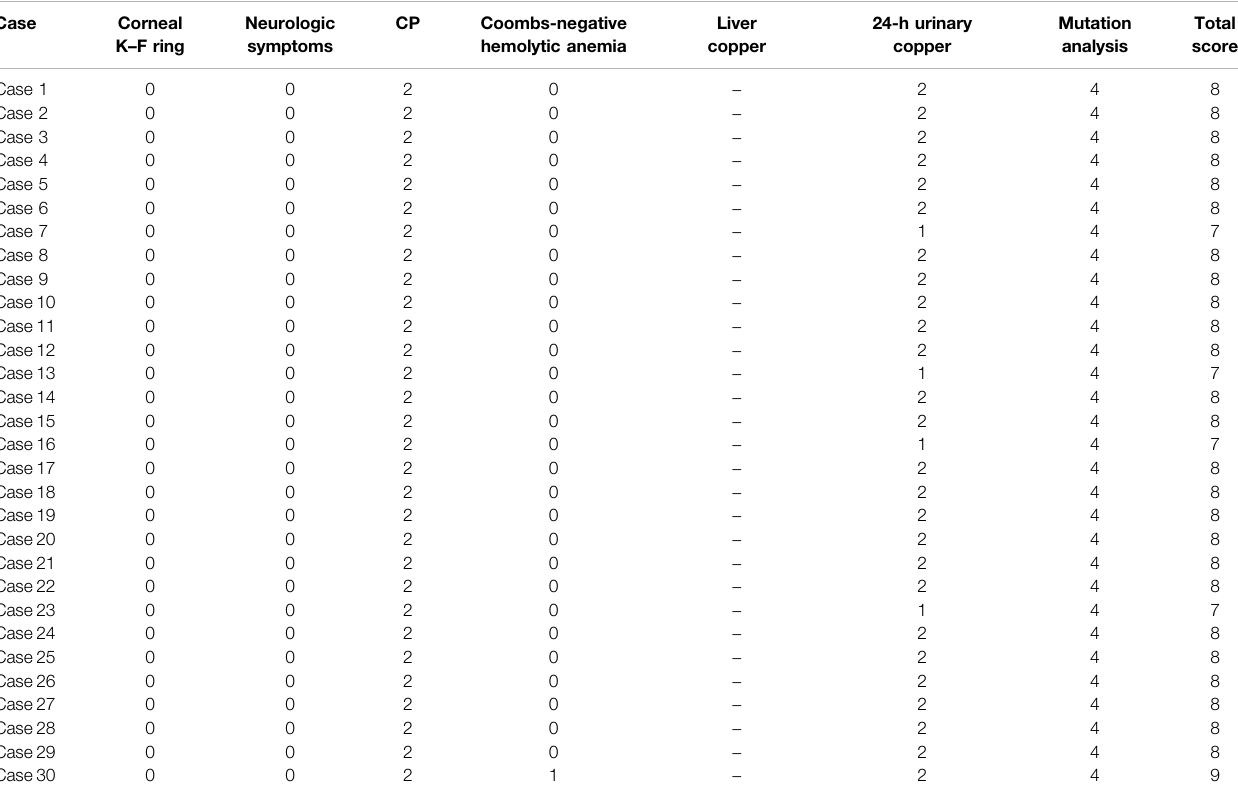
TABLE 3 | Diagnosis score of the cases with